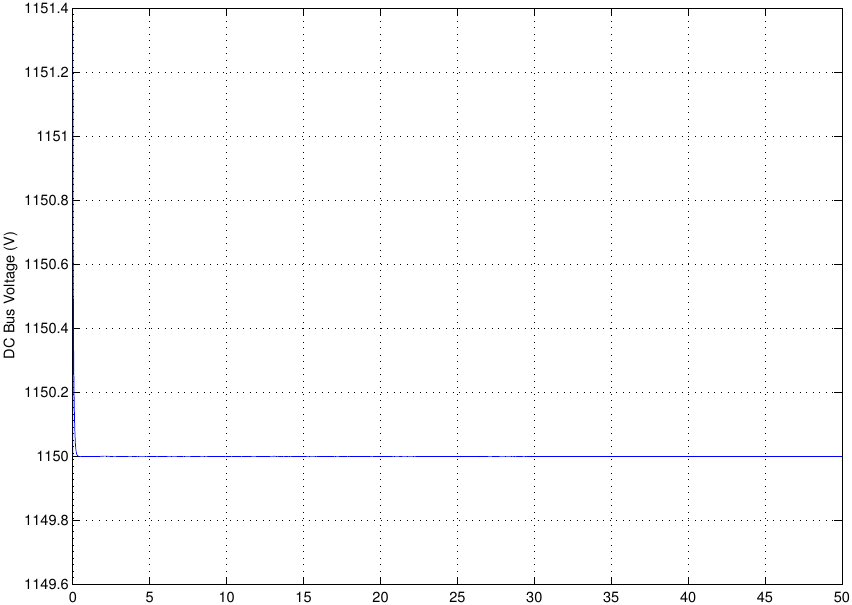
Figure 7. DC Bus